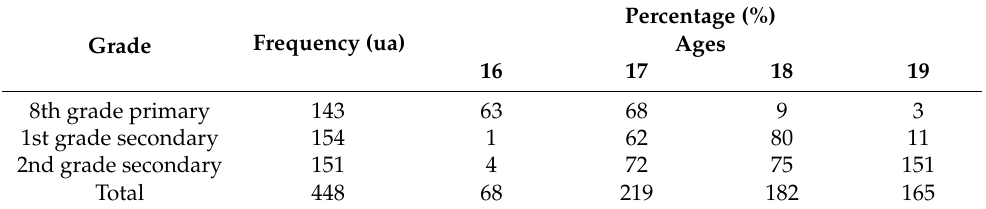
Table 1. Composition of the sample by grade and